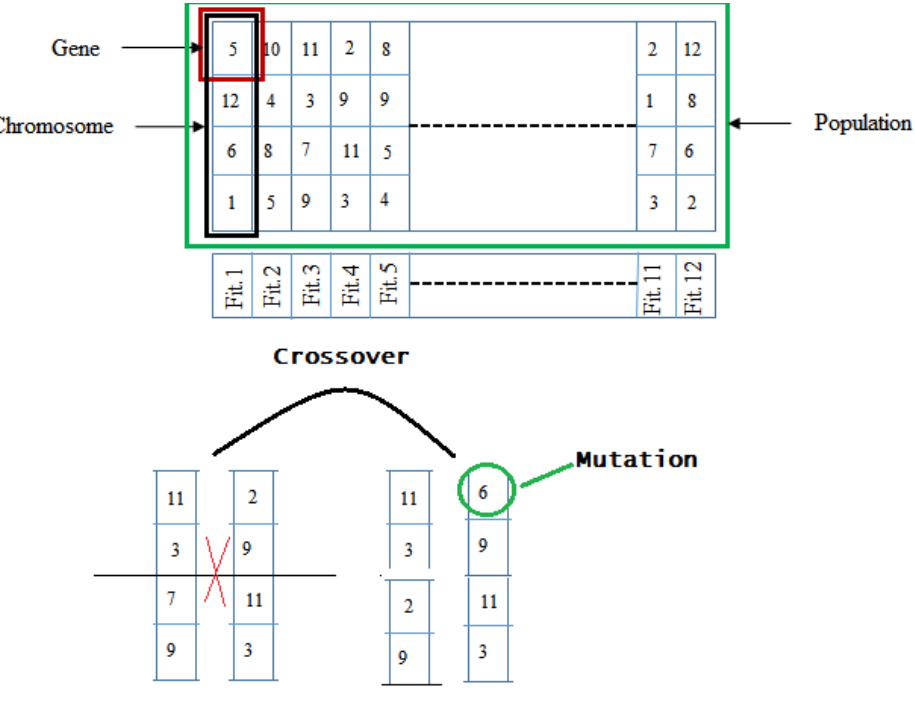
Fig. 2 Genetic algorithm coding